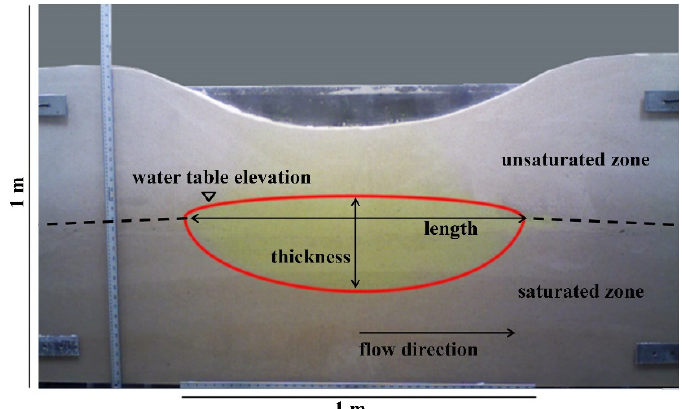
Figure 3. Diagram of observational data collected including water table elevation and IFL geometry (i.e., thickness, length) from previously conducted physical laboratory simulation.